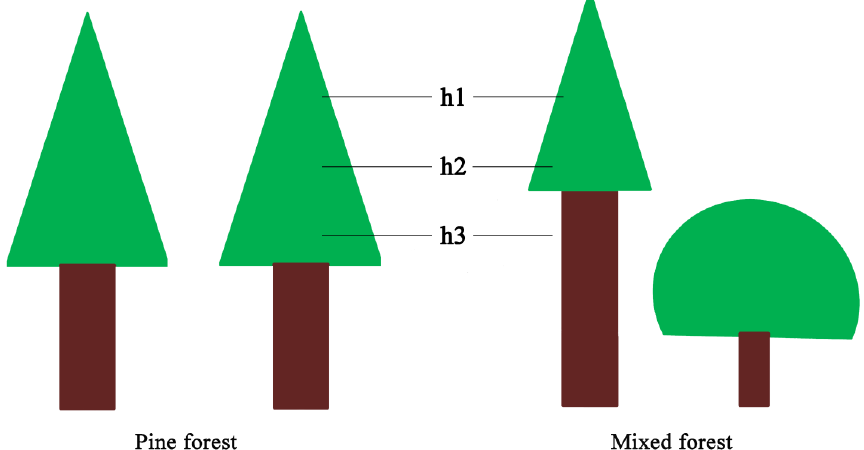
Figure 3. The position diagram of light transmittance measurement of Masson pine in pine forest and mixed forest of southern Jiangsu, China. h1, h2 and h3 indicate the position with the height of 11.0 m, 9.5 m and 8.0 m above ground but under the reference tree canopy at each sampling point, respectively.